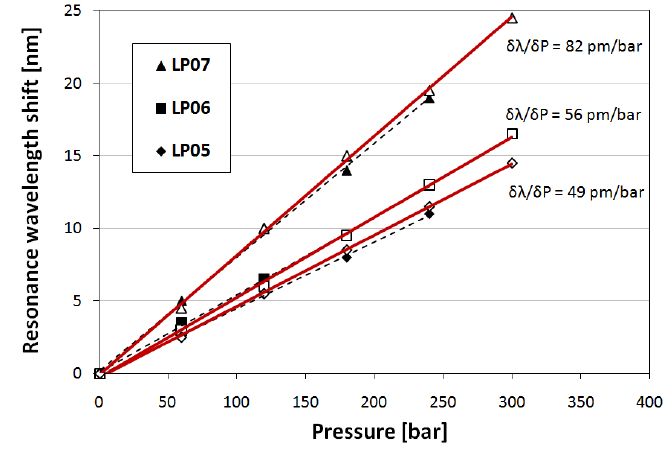
Figure 4. Pressure sensitivity for three observed resonances of the highest-order cladding modes comparing uncoated LPGs, investigated in water (black markers), and LPGs coated with SiN film (thickness of 28.5 nm and n = 2.293, white markers) investigated in x high-RI